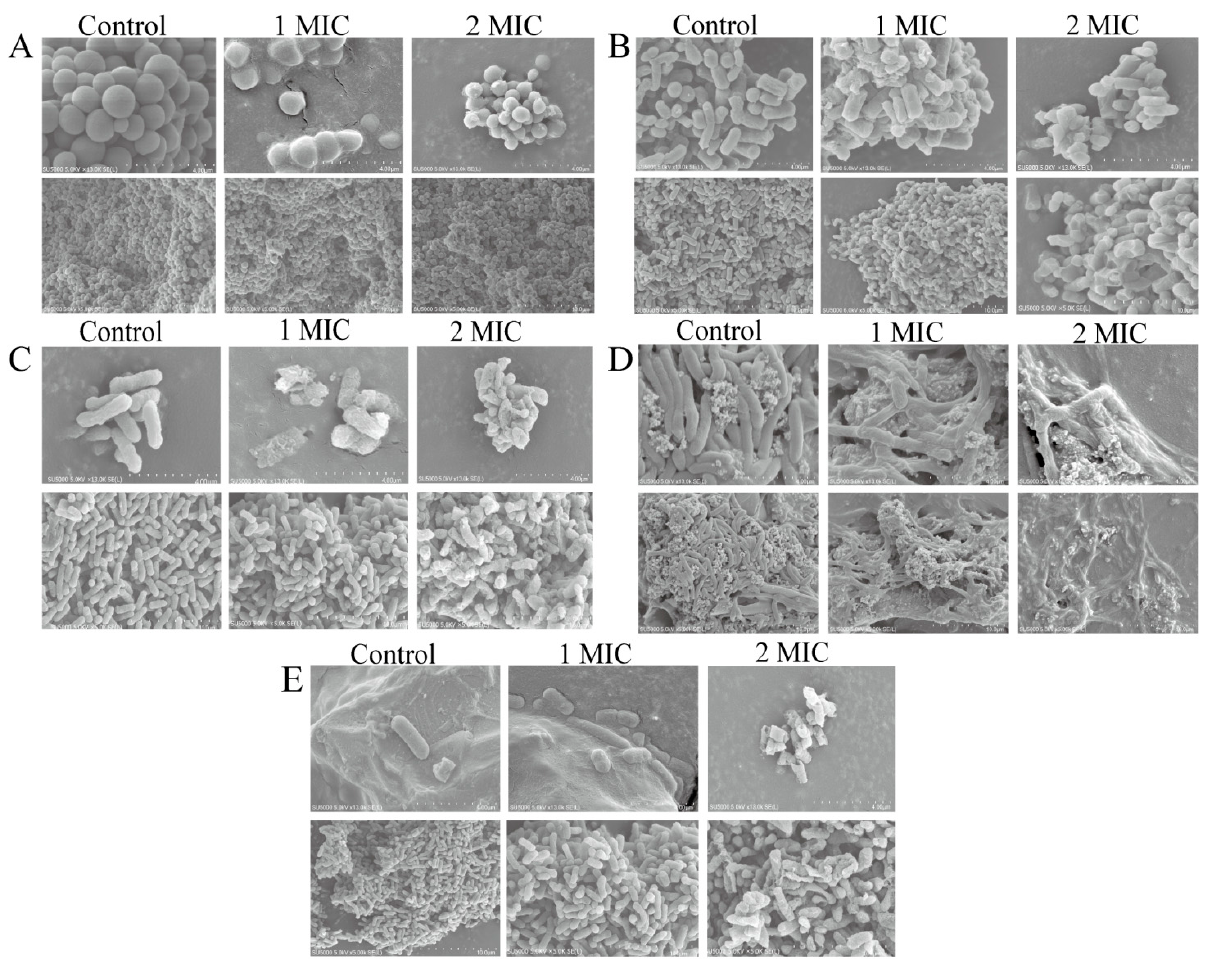
Figure 4. The SEM observation of bacterial cell morphological architecture change induced by the GMPE. ( A – E ) S. aureus ATCC8095, A. hydrophila , E. sakazakii CMCC45401, V. metschnikovii ATCC700040, and V. parahaemolyticus ATCC17802, respectively.